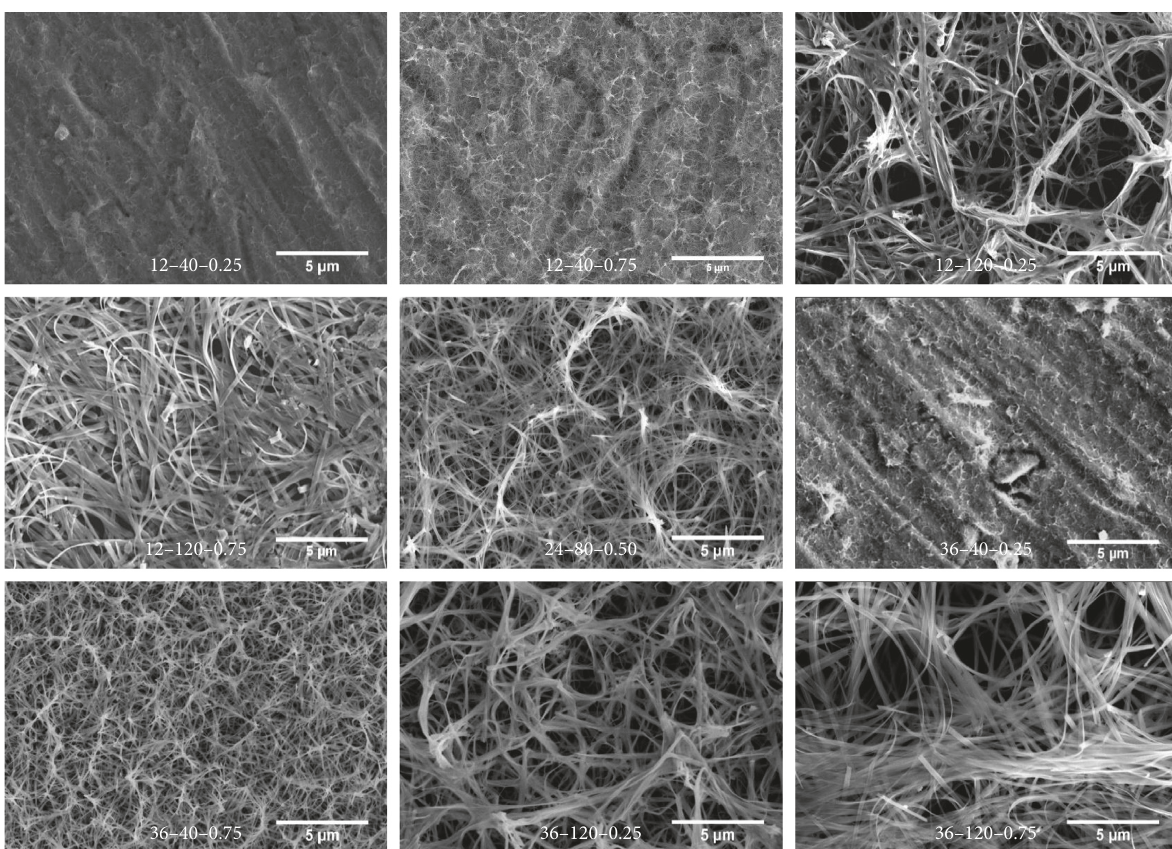
Figure 5: High magnification top-view SEM images of the samples as synthesized (all the samples have the same scale